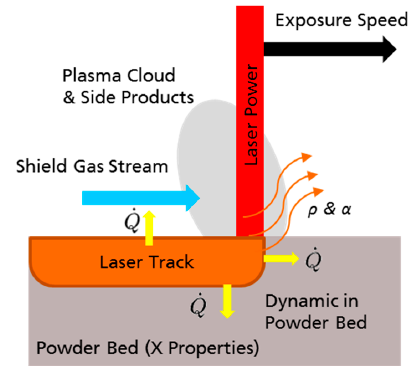
Figure 4. Parameters like absorption/reflection, heat flows, plasma cloud in combination with scan speed and side products influencing the interaction between laser beam and powder bed. 𝑄(cid:4662) : Heat flow; ρ reflectance; α : absorbance.